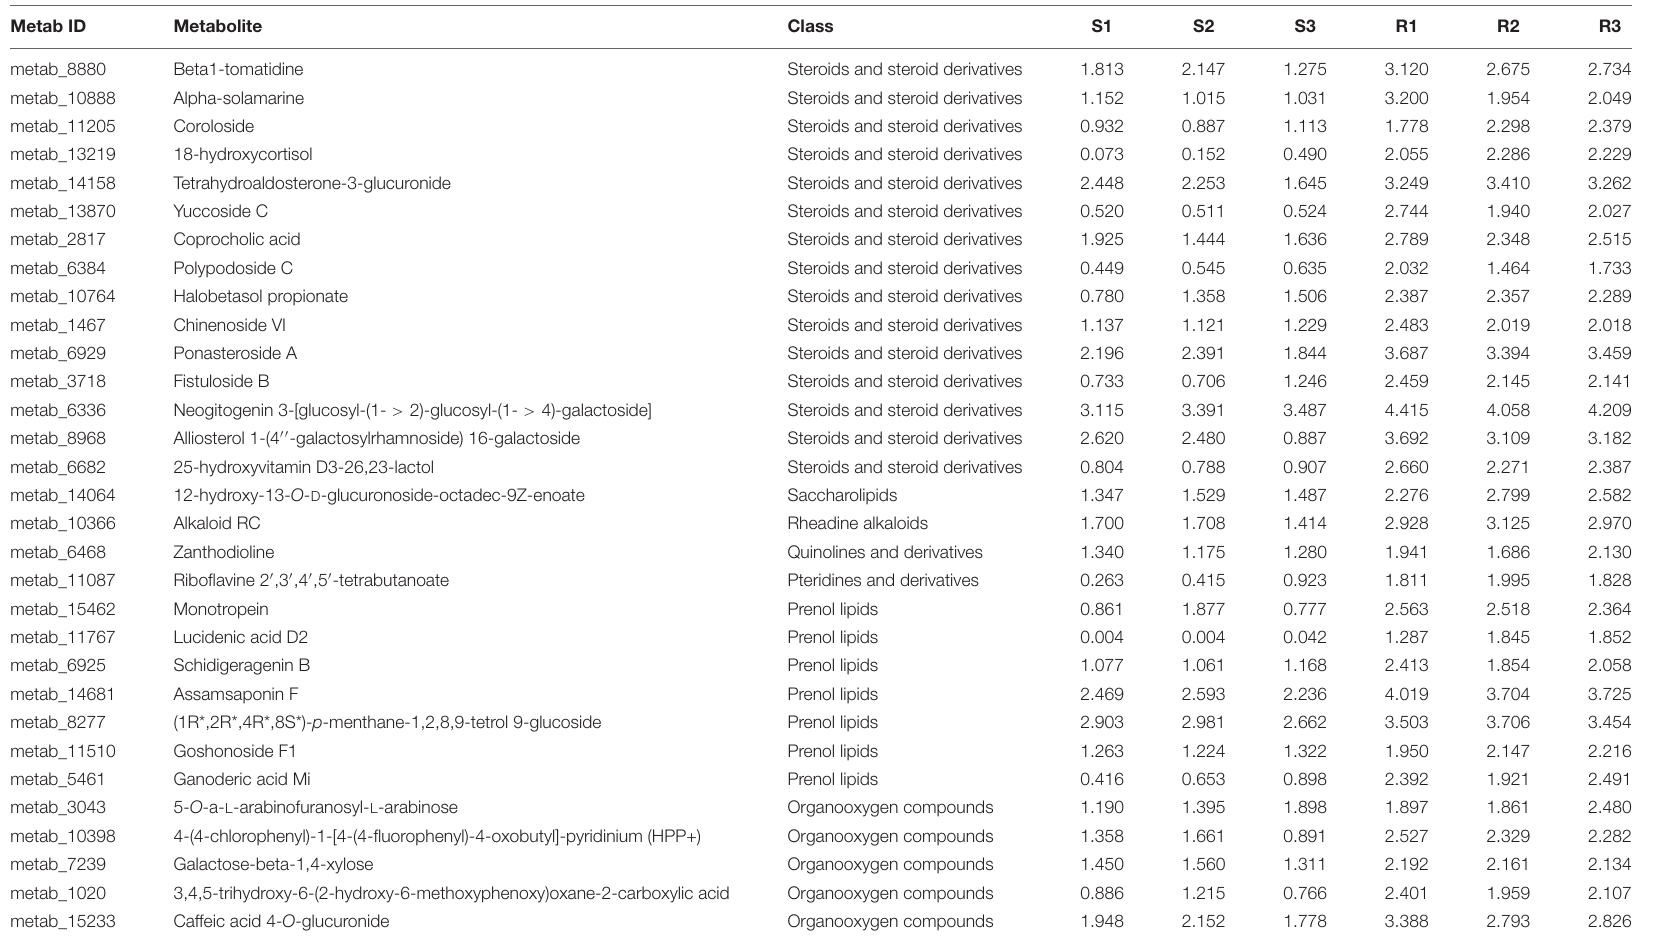
TABLE 1 | Late blight resistance-related (RR) metabolites identified in resistant potato cultivar. Metab